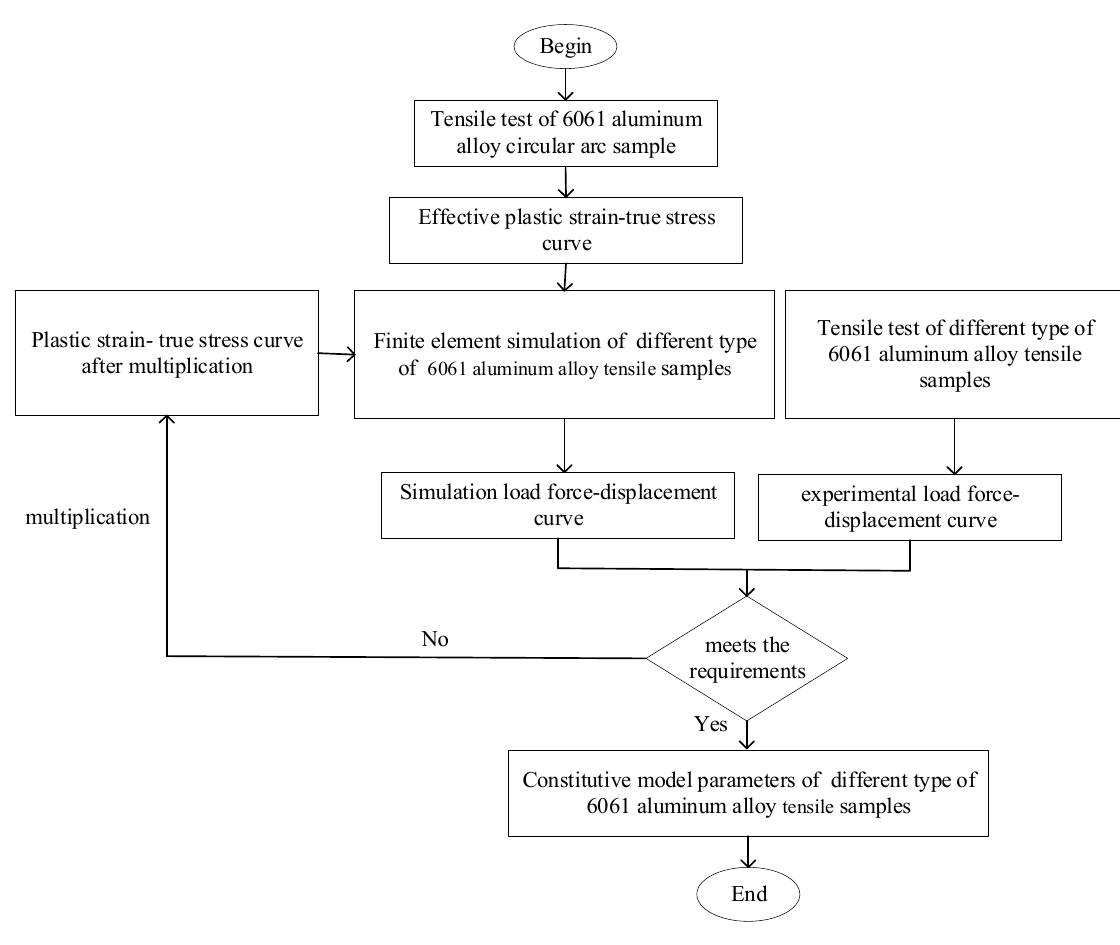
Figure 4. The flow chart for determining material plastic parameters of finite element model of 6061 aluminum alloy shear sample, arc-shaped notched sample, and V-shaped notched sample.